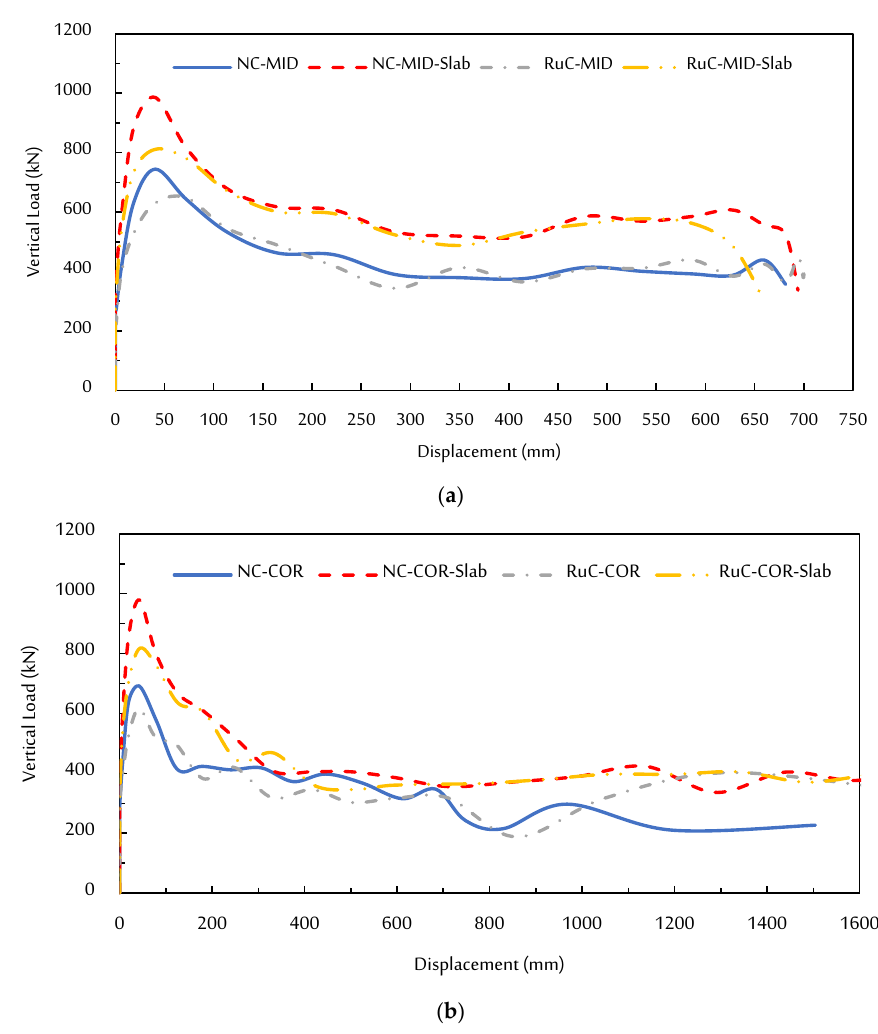
Figure 18. Vertical load–displacement curves: ( a ) Scenario “A” specimens and ( b ) Scenario “B” specimens.